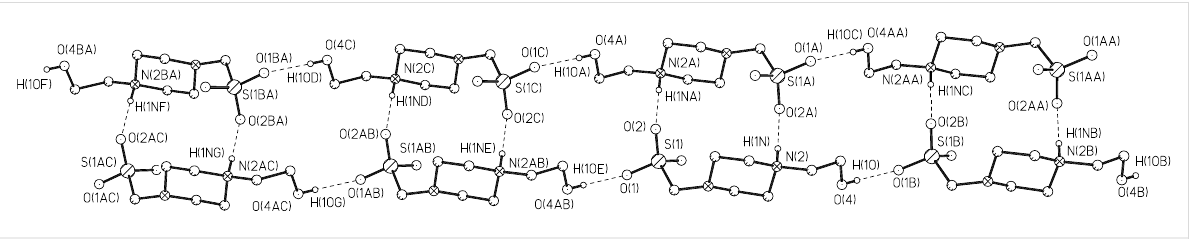
Figure 5: Hydrogen bonded molecular ribbon in solid phase 2 along [101].